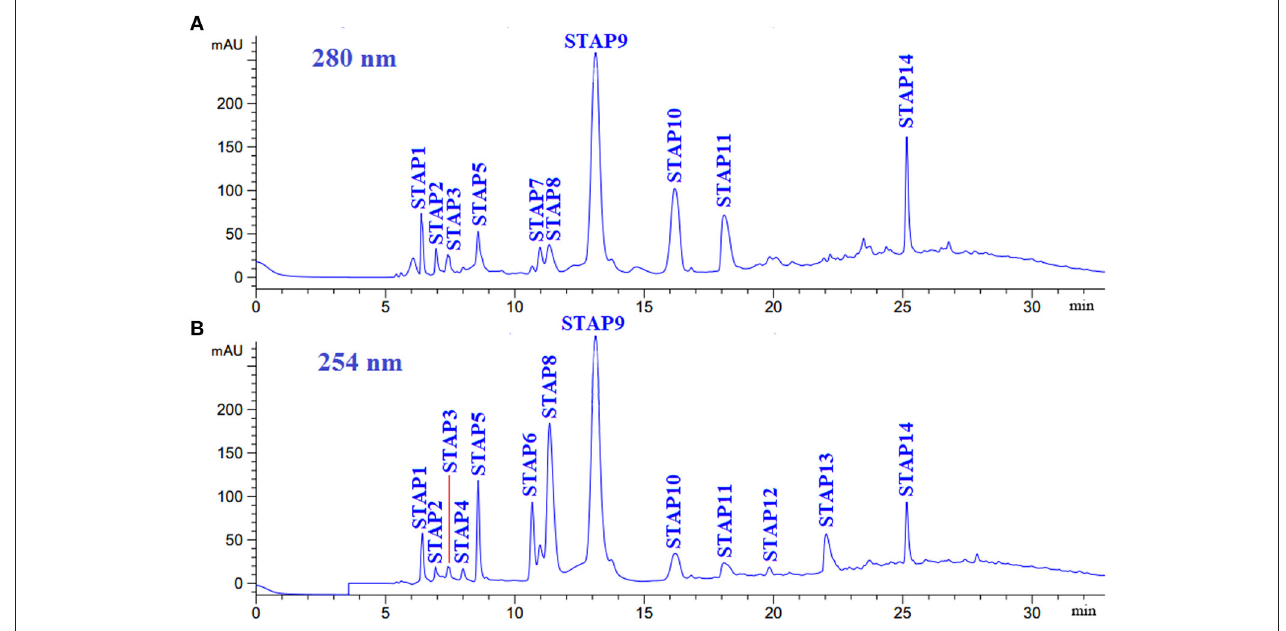
FIGURE 5 | Elution profiles of subfraction IG2 by RP-HPLC using a gradient of acetonitrile containing 0.06% trifluoroacetic acid at 280nm (A) and 254nm (B) .